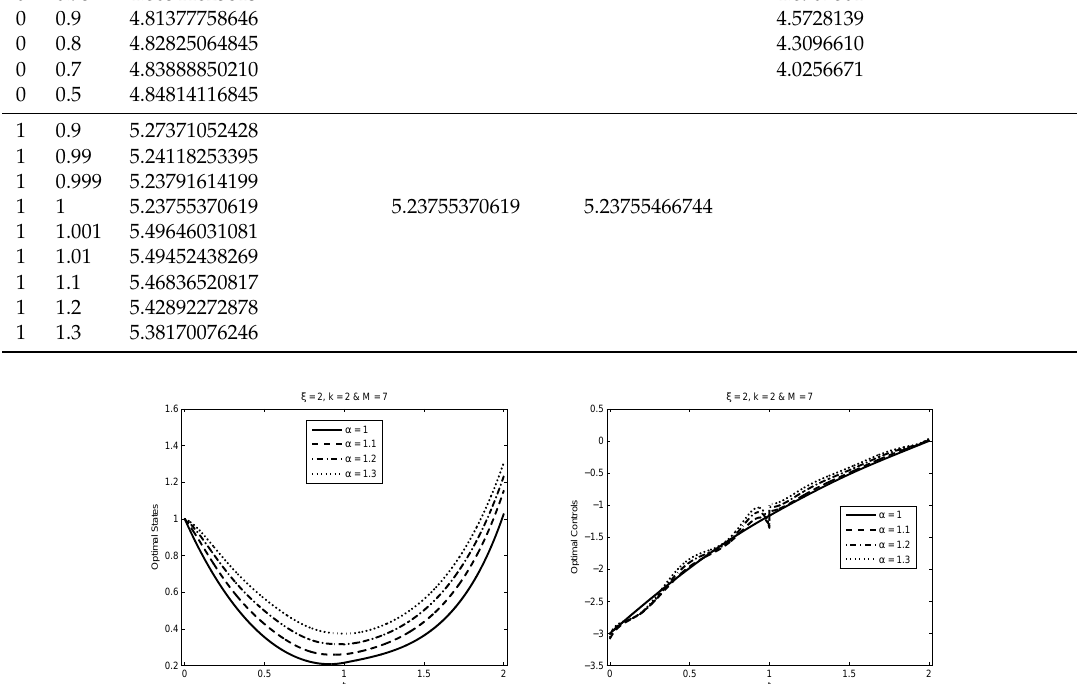
Figure 2. Optimal states and controls, Example 2 with the